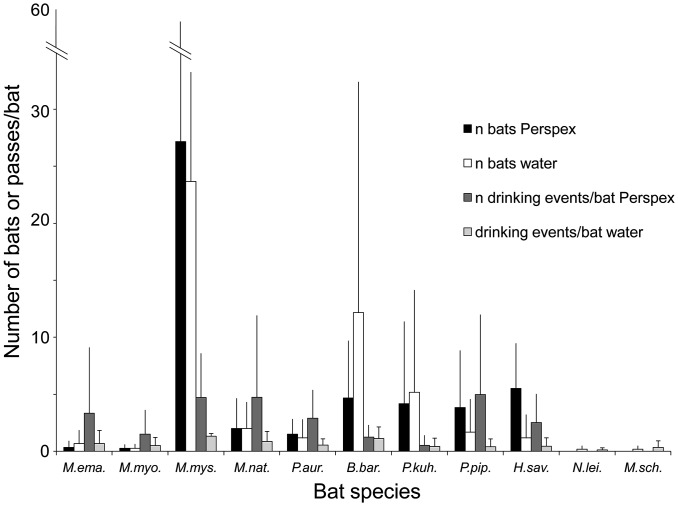
Mean numbers of bats and mean numbers of drinking attempts per bat on Perspex vs. water categorized by species.Error bars show the standard deviation. M. ema.  =  Myotis emarginatus, M.myo  =  Myotis myotis, M.mys.  =  Myotis mystacinus M.nat.  =  Myotis nattereri, P.aur.  =  Plecotus auritus, B.bar.  =  Barbastella barbastellus, P.kuh.  =  Pipistrellus kuhlii, P.pip.  =  Pipistrellus pipistrellus, H.sav.  =  Hypsugo savii, N.lei.  =  Nyctalus leisleri, M.sch.  =  Miniopterus schreibersii.